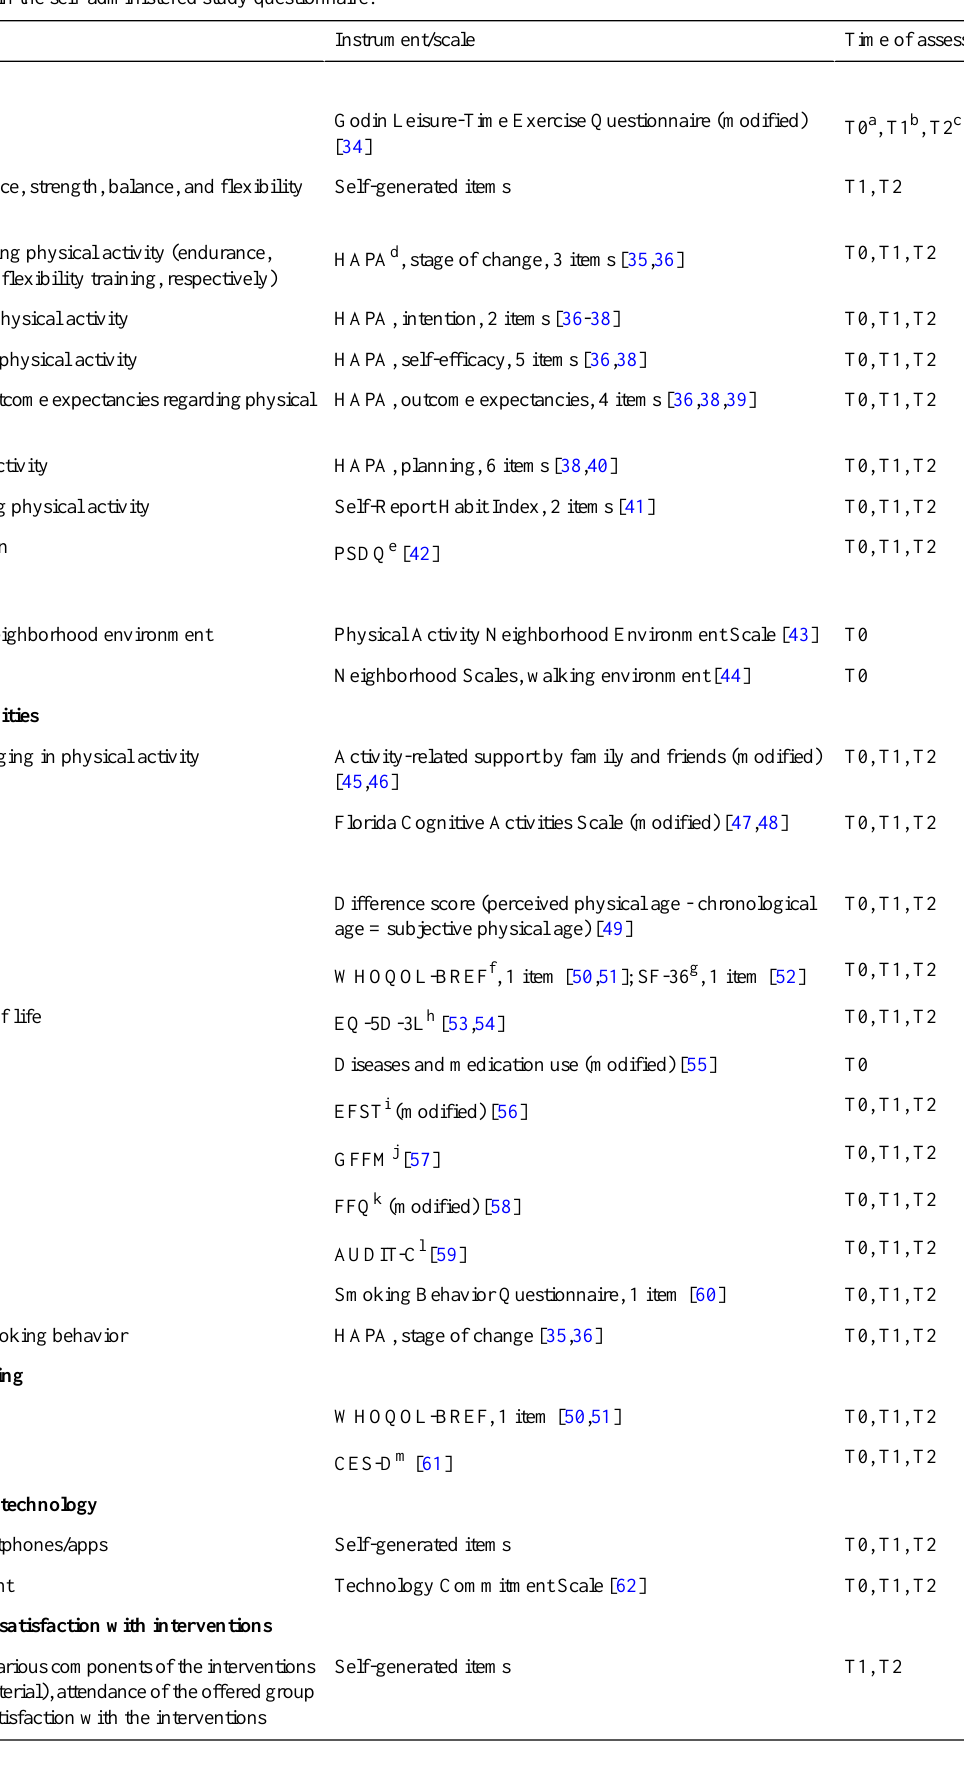
Table 1. Measures assessed in the self-administered study